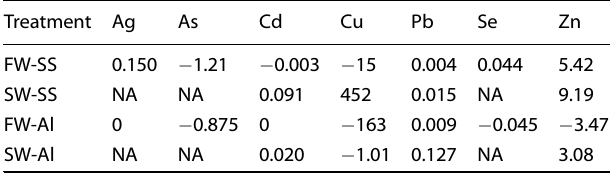
Table 4. Change in metal concentrations (µg L − 1 ) following treatment measured by